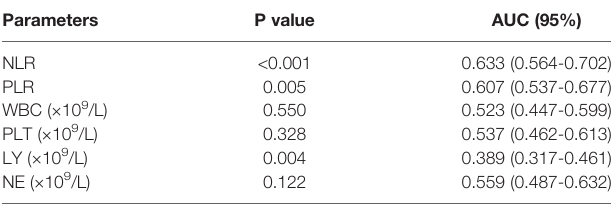
PLT, platelet counts; NE, neutrophils counts; LY, lymphocytes counts; PLR, platelet ‐ to ‐ lymphocyte ratio; WBC, white blood cell counts; NLR, Neutrophil-to-lymphocyte ratio.